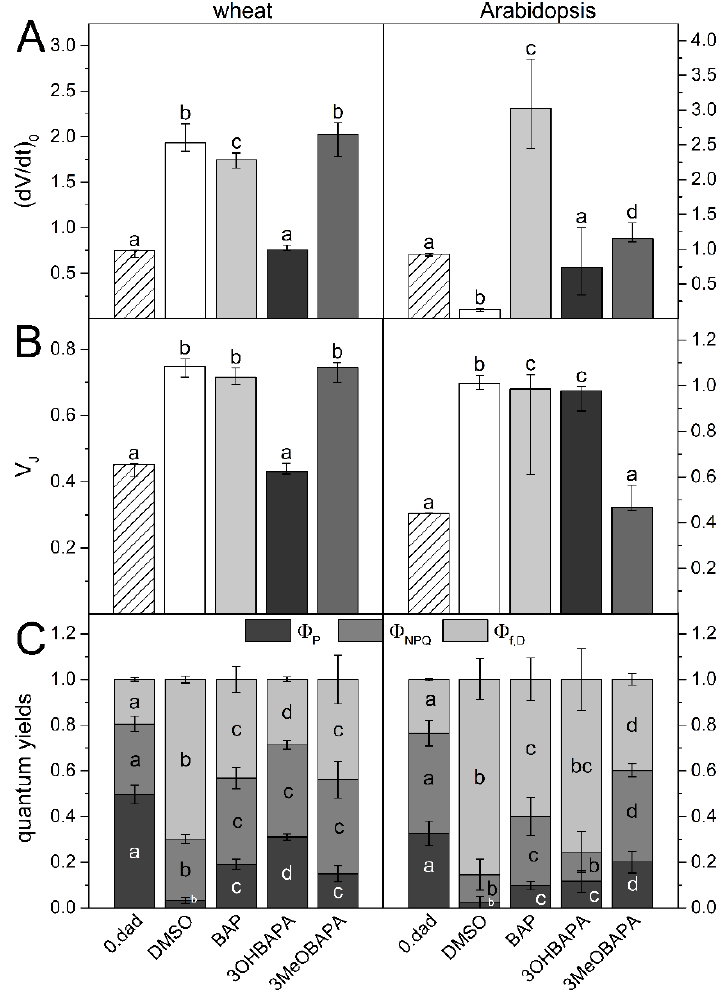
Figure 4. ( A ) The initial slope of the O–J Chl fluorescence rise (dV/dt) 0 , ( B ) the relative variable fluorescence at the J step (V J ) and ( C ) quantum yields of photosystem II (PSII) photochemistry ( Φ P ), regulatory non-photochemical quenching ( Φ NPQ ) and non-regulatory dissipation processes ( Φ f,D ) in control (0. dad) and detached leaves of wheat and Arabidopsis after 6 days of dark-incubation in 0.1% DMSO or 10-µmol·L − 1 solutions of BAP, 3OHBAPA and 3MeOBAPA. Medians and quartiles are presented ( n = 5–12). Different letters indicate a statistically significant difference between treatments within a plant species ( p < 0.05; Student’s unpaired t -test).